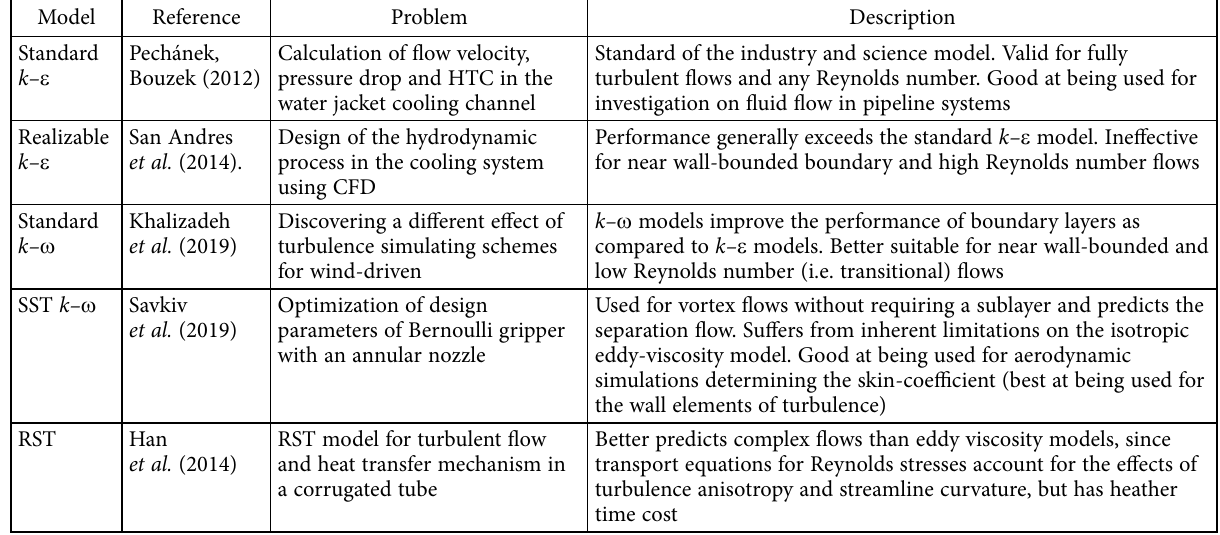
Table 1. Review of turbulence